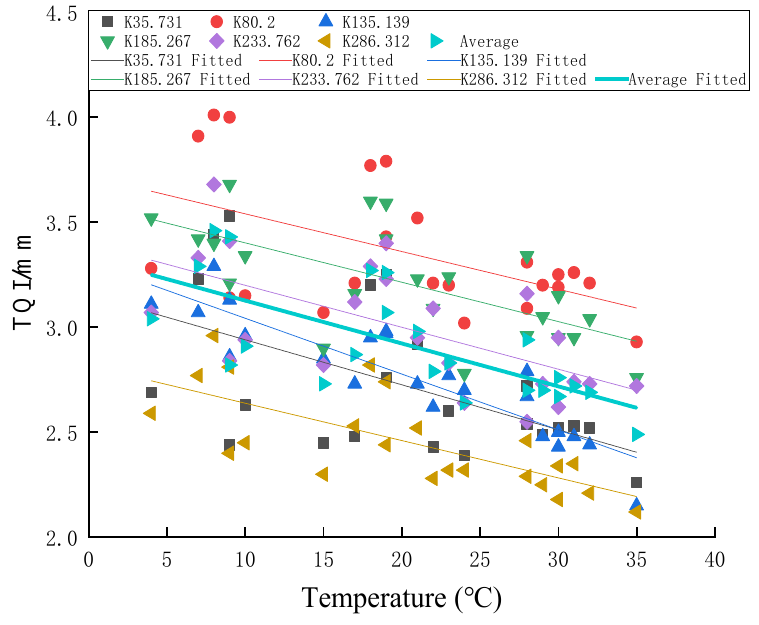
Figure 8. Variation of TQI with temperature.